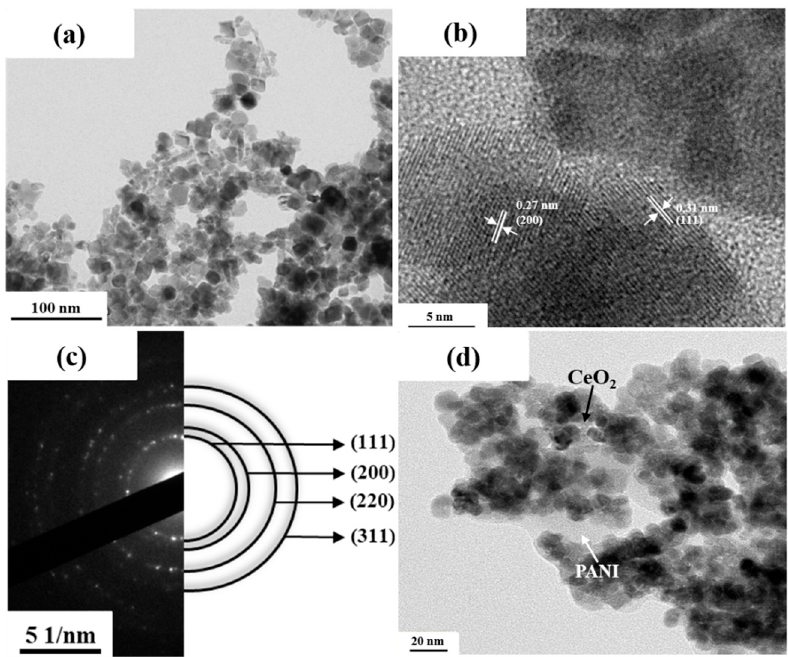
Figure 3. ( a ) TEM image, ( b ) HR-TEM lattice fringe image and ( c ) SAED pattern of the uncoated CeO 2 powder synthesized by precipitation. ( d ) TEM image of the 4 wt % PANI-coated CeO 2 powder (PC004). FTIR can be used to determine the functional group and intramolecular bonding of the